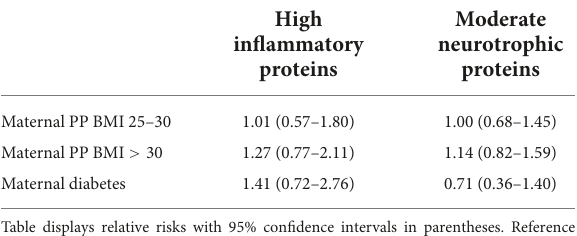
TABLE 6 Adjusted analyses for inflammatory and neurotrophic protein outcome by maternal BMI or diabetes